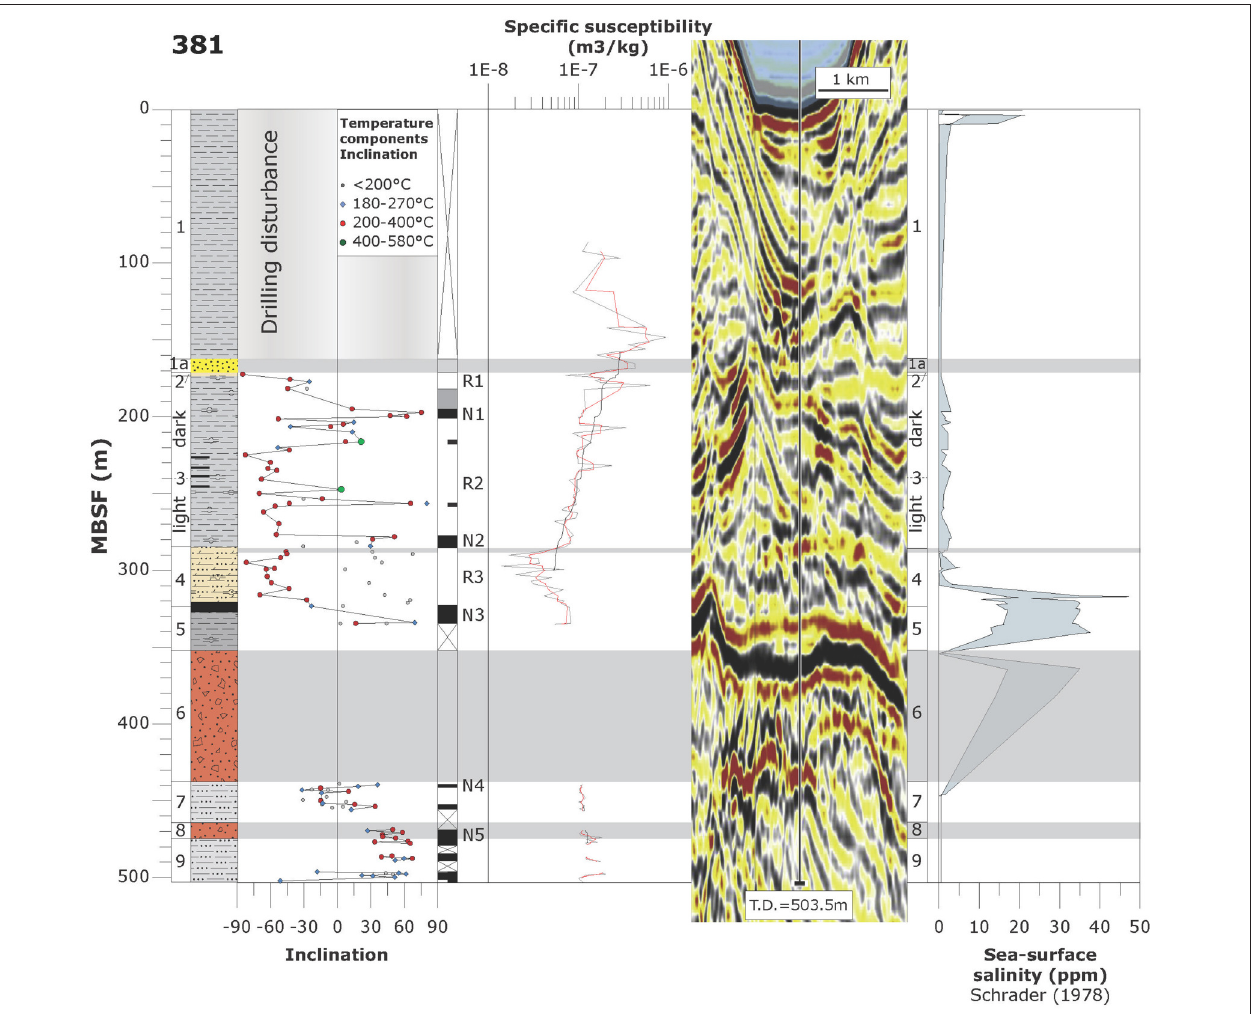
FIGURE 8 | Magnetostratigraphic results for Hole 381 compared to previously published datasets. From left to right: Depth-scale; lithological units; lithology (similar to Figure 1 ); Measured inclination; Polarity interpretation; Polarity zone label; specific magnetic susceptibility (gray: measured data, red: three point moving average; black: 25 point moving average); Depth converted seismic transect across the drilling location of Hole 380/380A ( Tari et al., 2015); lithological units; diatom-based sea-surface salinity (Schrader, 1978). Horizontal gray bars indicate hiatuses in the